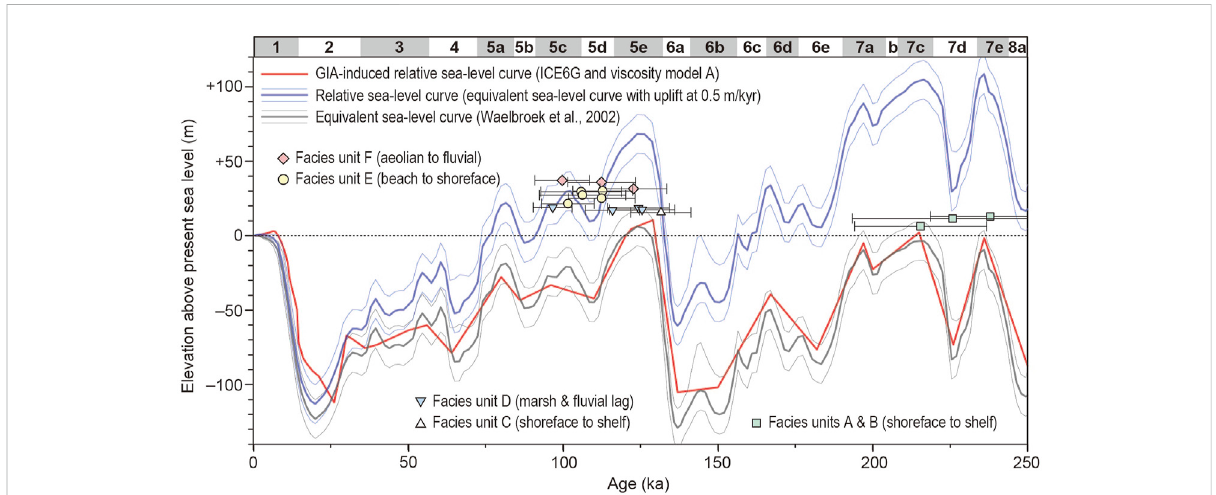
FIGURE 8 Sea-level curves compared with the plots of pIRIR 225 ages and elevations of samples in core GS-HKT-1. An expected age overestimate due to theresidualdose,estimatedas4.2±1.5 kyr,wassubtractedfromthepIRIR 225 ages(correctedwiththeaveragefadingrate).Thebluelinerepresentsa relative sea-level curvewith an uplift rate of 0.5 m/kyr, whichassumes theupper boundary of Unit E (orsubunitE-3, foreshore facies) represents the sea-level highstand of the MIS 5c. GIA (Glacial Isostatic Adjustment)-induced relative sea-level curve was calculated based on the deglaciation model ICE6G_C (Argus et al., 2014). In order to have one cycle ice history only in ICE6G_C, the pre-history of equivalent sea-level changes before 122 ka was adopted from Waelbroeck et al., 2002. The viscosity model (model A) adopted here assumes that the elastic thickness is 50 km and the upper and lower mantle viscosities are 2 × 10 20 , 2 × 10 22 Pa s, respectively (Okuno et al.,